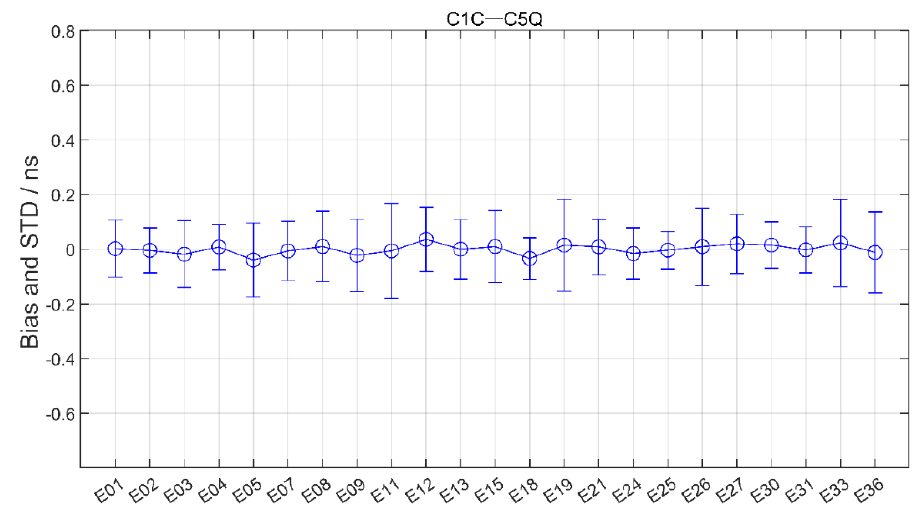
Figure 24. Comparison results between DCB and CAS products of Galileo satellite.